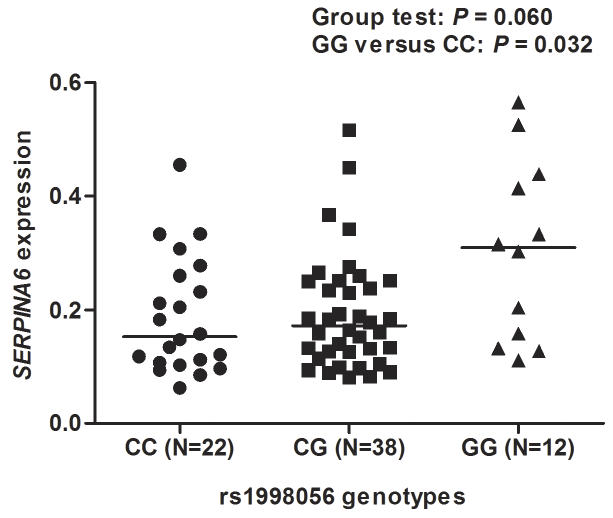
Figure 2. SERPINA6 mRNA levels in liver tissues from different genotype carriers of rs1998056. Vertical scatter plots indicated relative gene expression of SERPINA6 for 22 CC, 38 CG and 12 GG carriers. Horizontal line indicated median mRNA level of each genotype group.